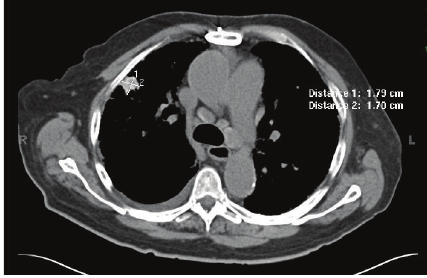
Figure 3: HRCTshowing no interval change, when compared to CT angiogram, of multiple right upper lobe pulmonary parenchymal nodules, right pleural effusion, and diffuse fibrotic changes. The most prominent nodule measures 1.8 × 1.7